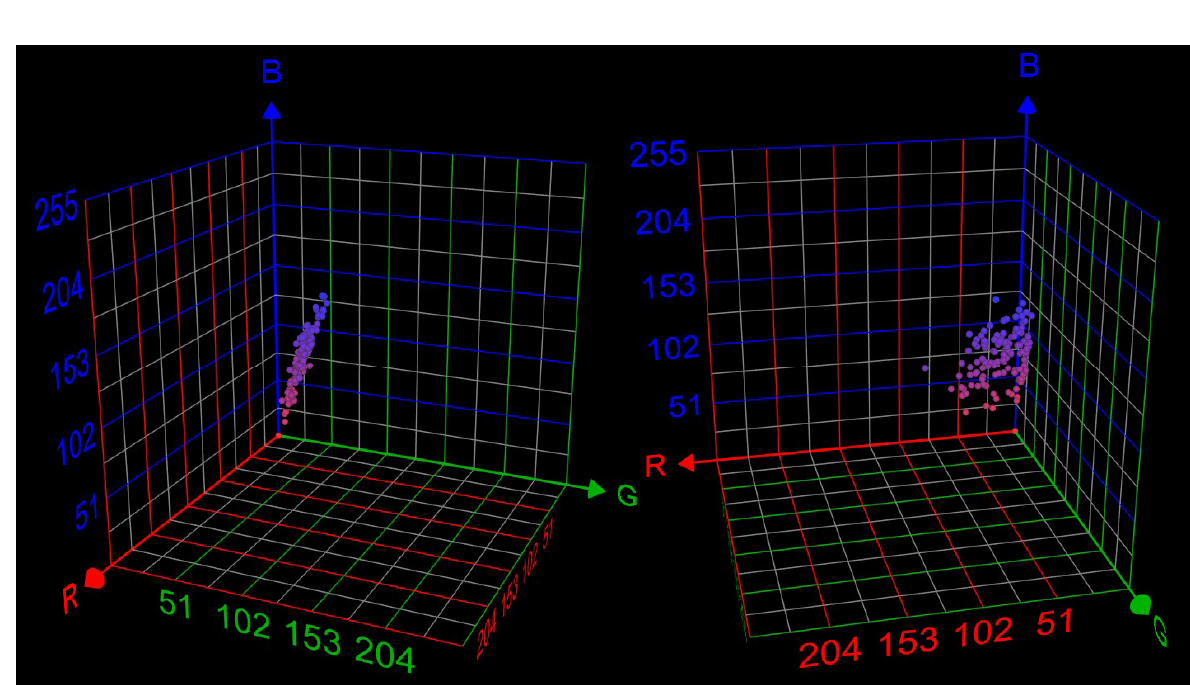
Figure 7. The 3D scatter plot of RGB values corresponding to the averaged CL color of all the analyzed samples. The plot is shown in two different perspectives to highlight that the values concentrate on a plane.